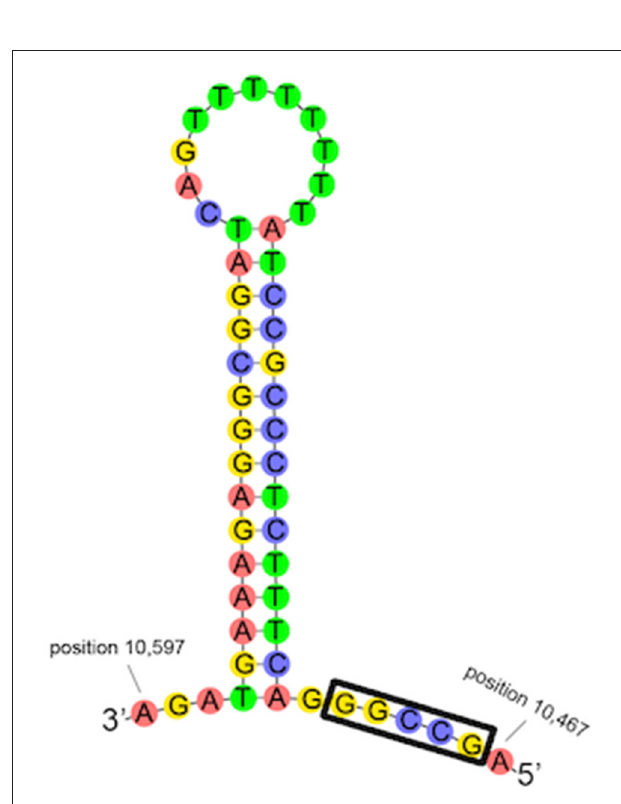
FIGURE 8 | Predicted folding structure of A. limnaeus origin of light-strand replication (Ori-L) using Geneious. The sequence is located between tRNA-Asn and tRNA-Cys and has a high probability of folding into a stable stem-loop structure. The conserved sequence 3 ′ -GGCCG-5 ′ is indicated with a black